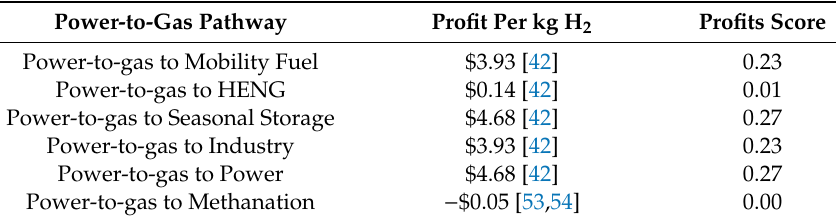
Table 10. Annual Profits for power-to-gas